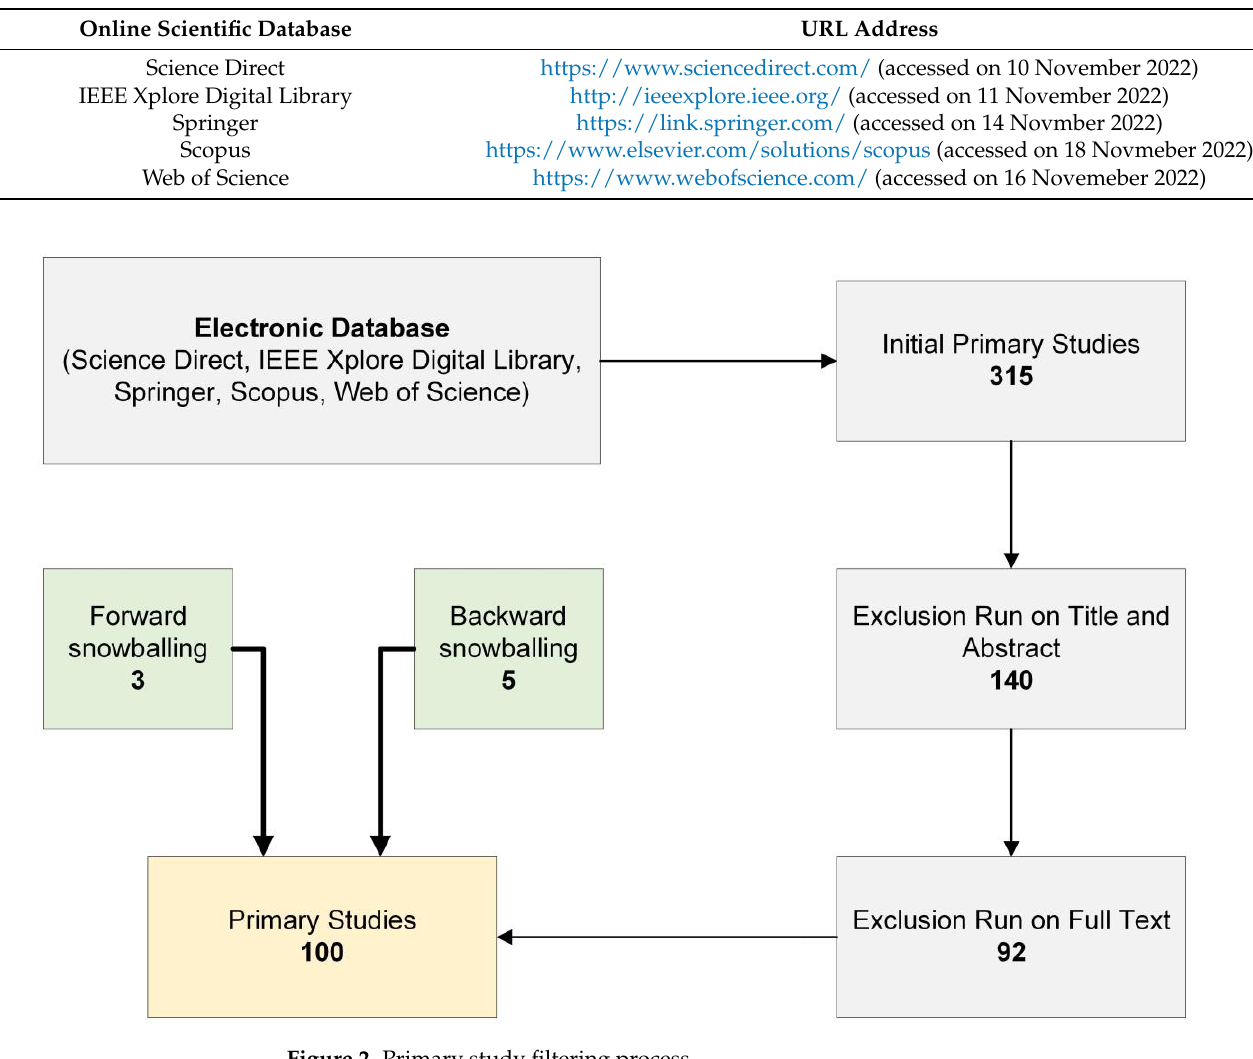
Figure 2. Primary study filtering